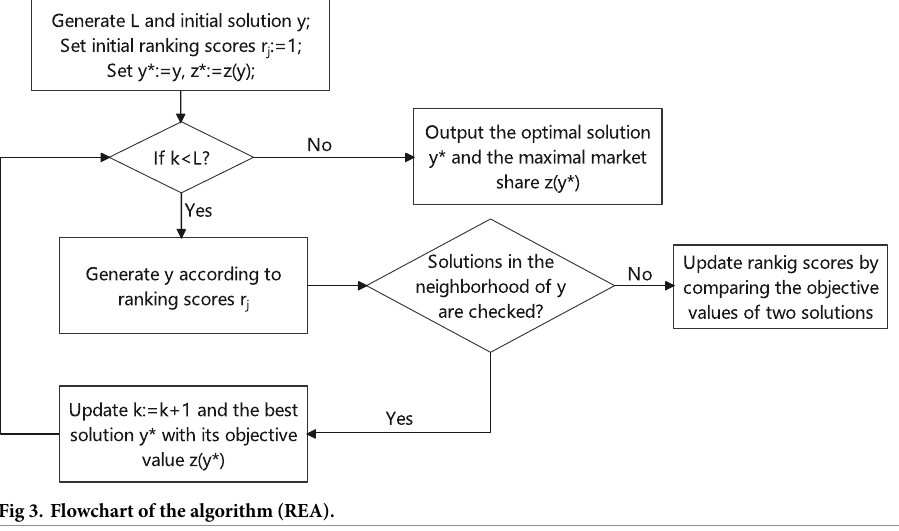
Fig 3. Flowchart of the algorithm